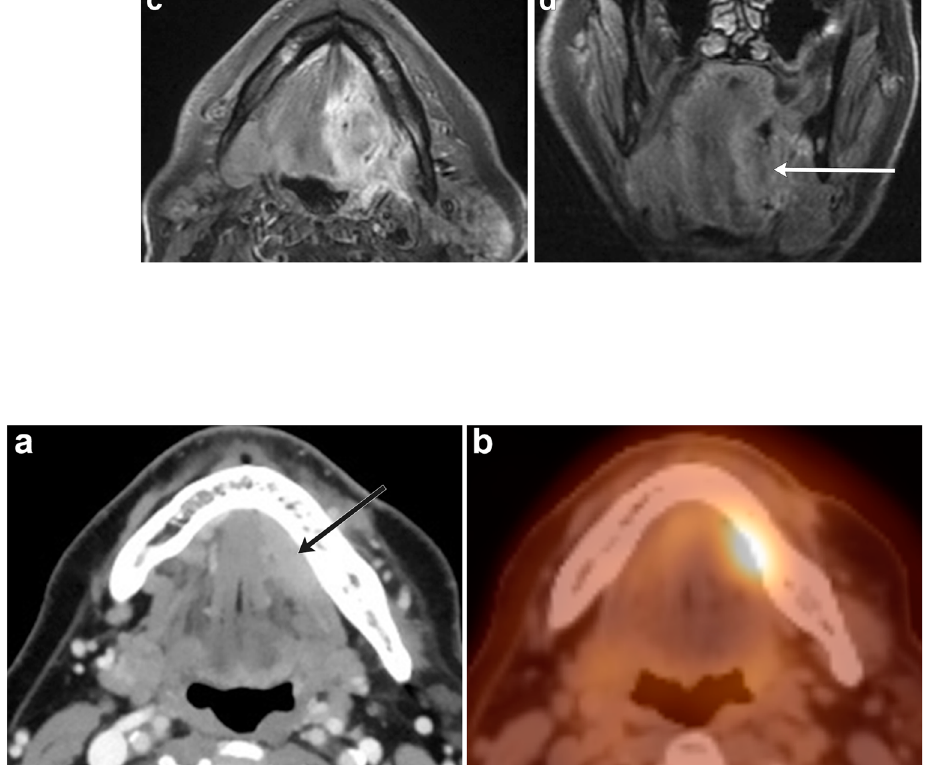
Fig. 14 Squamous cell carcinoma involving the left sublingual space. Infiltrative lesion centred within the left sublingual space, which demonstrates heterogenous intermediate to high signal on T2- weighted MRI ( a ) and isointensity compared with adjacent musculature on T1- weighted MRI ( b ). c Post-contrast axial and d coronal T1-weighted MR images reveal heterogenous enhancement ( arrow )